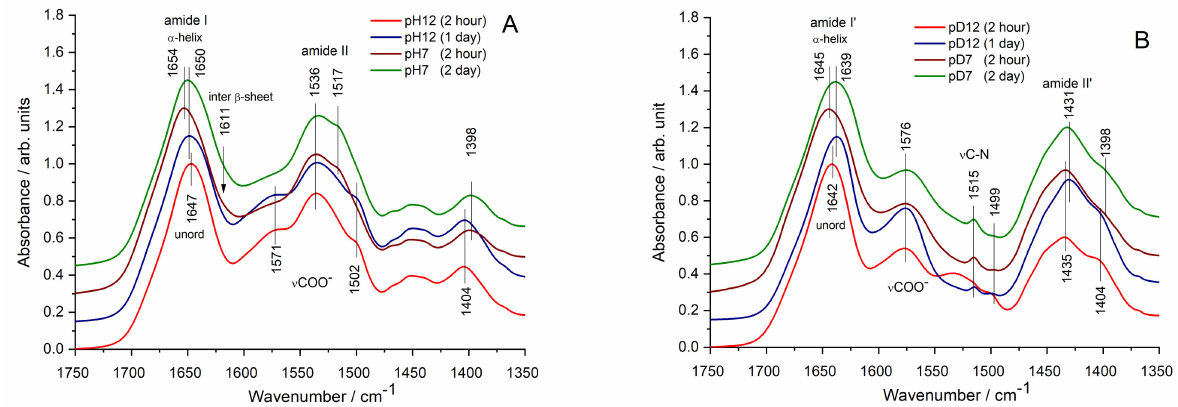
Figure 2. Amide I and amide II regions of IR spectra obtained from BSA–AU bioconjugate samples in H 2 O ( A ) and in D 2 O ( B ). Spectra are normalized to the highest amide I peak and shifted vertically for improved